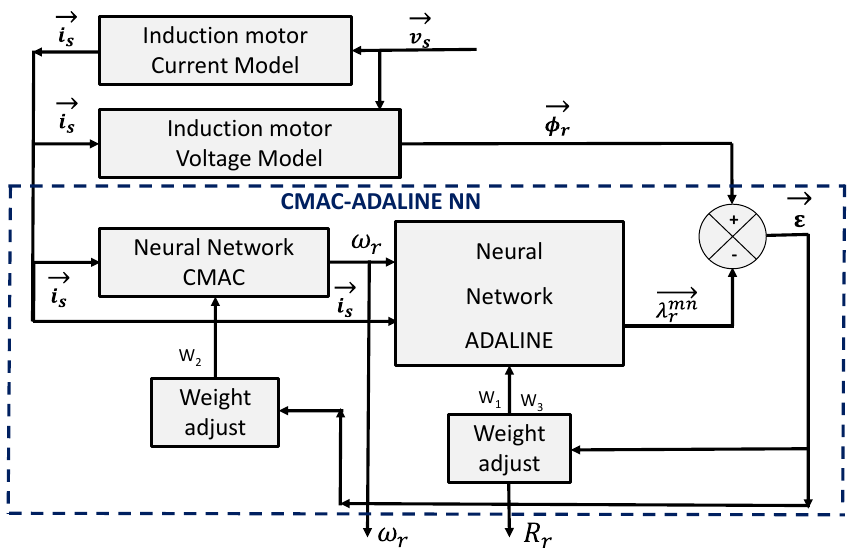
Figure 2. Cerebellar model articulation controller (CMAC)-adaptive linear neuron (ADALINE) structure for the parameter